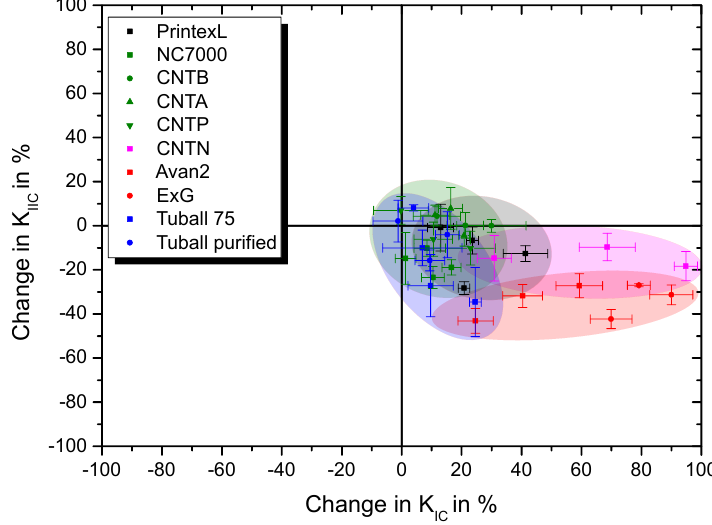
Figure 19. Summary of resulting K IIC and K IC values for all investigated particle types in Epikote